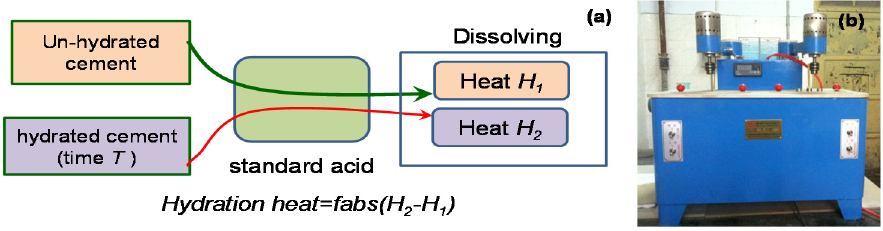
Figure 1. Setup for the hydration heat test. H 1 , un-hydrate cement. H 2 , hydrated cement.